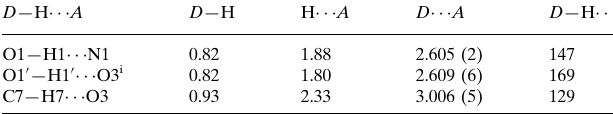
Hydrogen-bond geometry (A˚ , (cid:1)